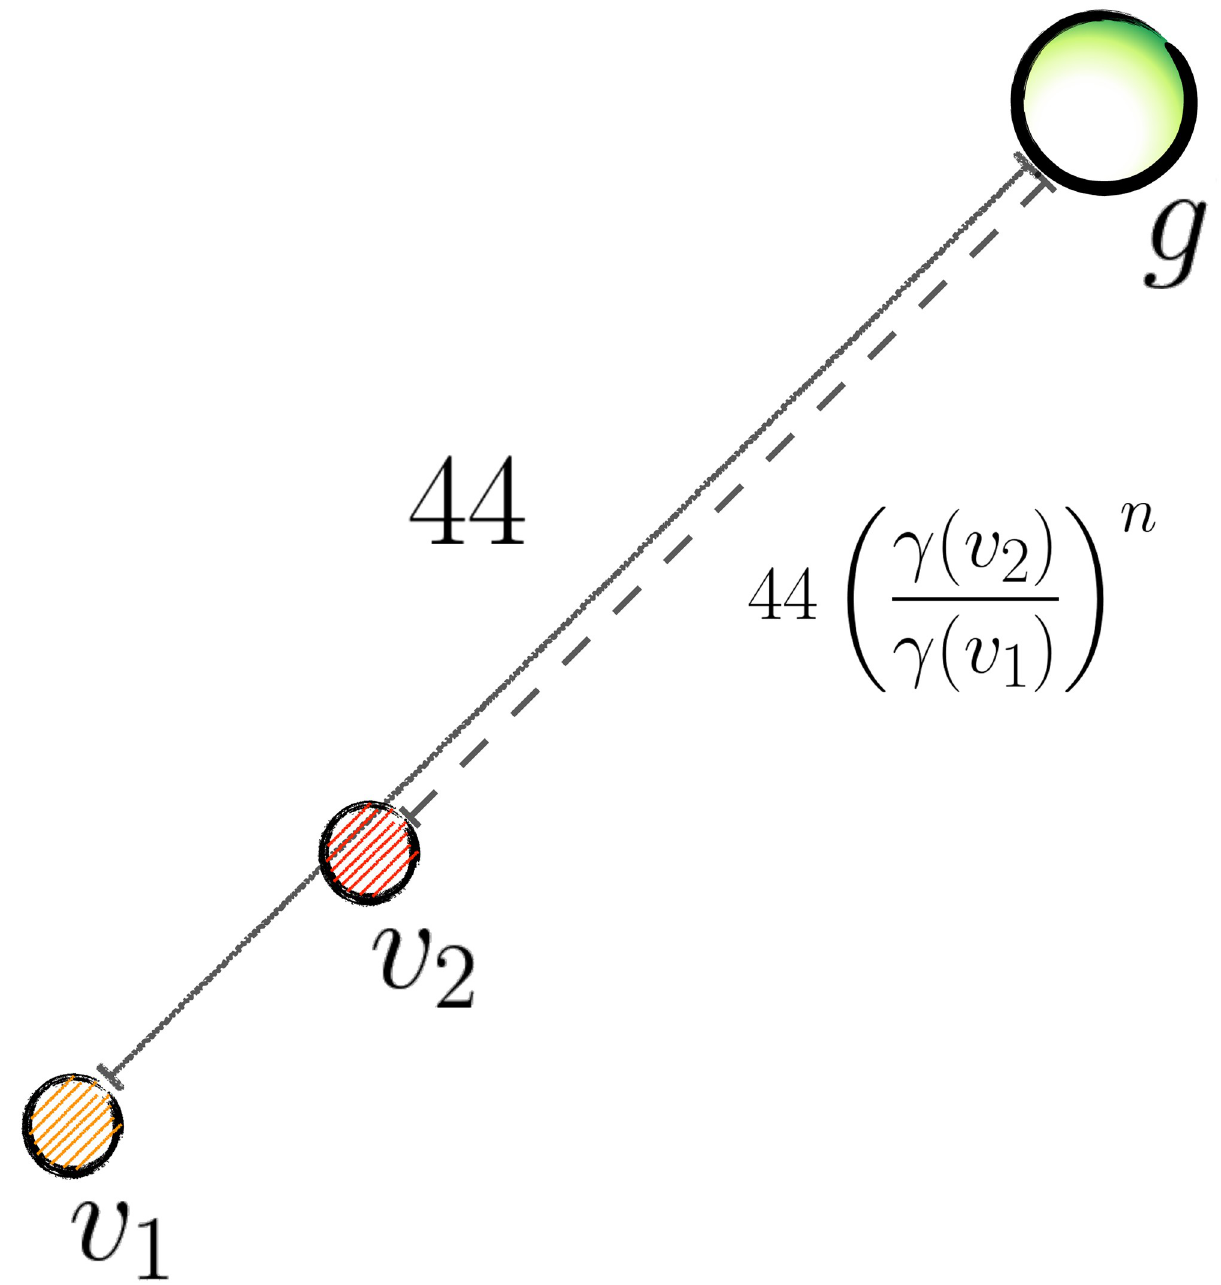
Fig 3. Illustration of single-goal trials (SGTs). Vehicle’s colors in this figures are random. In SGTs, the vehicles’ relative positions from the goal ( g ) depend on their guidability. The more controllable (yellow, in figure) vehicle’s distance from g is always 44 Manhattan steps. The other (red) vehicle’s distance is instead a fraction of this distance equal to powers (the exponent n takes the values 1,2,3 and 4) of the ratio of the guidabilities, i.e. γ ( v 2 )/ γ ( v 1 ). Setting the distance of the red vehicle from g to be dependent on this ratio promotes harder decision making; and we empirically verified that it ensures that v 1 is the correct choice exactly half of the time if subject pressed at a frequency of 8 Hz (in high influence conditions, it is best to choose the most controllable vehicle when n < 3, and the closer vehicle when n > 2). Thus, choosing the same vehicle on all four SGTs is then wrong. If the two vehicles are equally controllable, their distance from the goal is randomly 44 and 38 Manhattan steps, and of course the closest vehicle to g is always the right choice. The probability of making the goal in low influence conditions is instead hopeless, by design (no win was recorded). Rewards associated with the single goal are pseudorandomly distributed in a uniform interval between 50 and 80 pence, in steps of 10. The order of the four SGTs is randomized, but they always occur at the end of each block, when the guidability of each vehicle can be assumed to be known by participants.